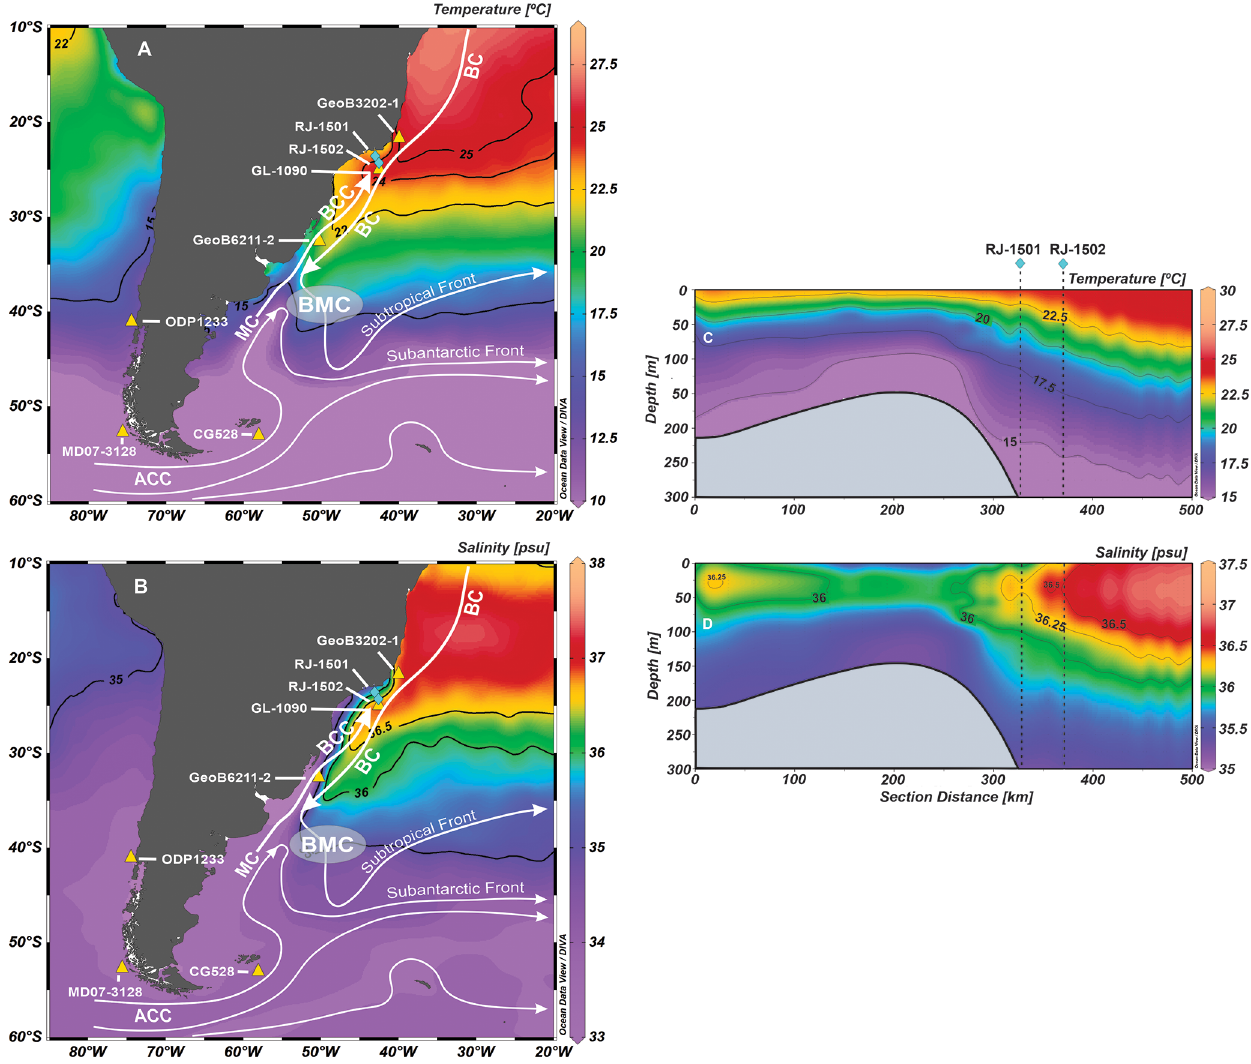
Figure 1. Position of marine sediment cores RJ-1501 (23 ◦ 58 (cid:48) 14.3 (cid:48)(cid:48) S, 43 ◦ 06 (cid:48) 35.1 (cid:48)(cid:48) W; 328m water depth) and RJ-1502 (24 ◦ 32 (cid:48) 57.6 (cid:48)(cid:48) S, 42 ◦ 55 (cid:48) 42.9 (cid:48)(cid:48) W; 1598m water depth) in the upper and lower continental slope of the subtropical western South Atlantic and other cores (GeoB3202-1, GL-1090, GeoB6211-2, CG528, MD07-3128, and ODP1233) discussed in this study. The maps feature the annual (a) sea surface temperature and (b) sea surface salinity. The transects on panels (c) and (d) show the annual water mass structure relative to temper- ature and salinity, respectively. Acronyms on panels (a) and (b) define the Brazil Current (BC), Brazilian Coastal Current (BCC), Malvinas Current (MC), Brazil–Malvinas Confluence (BMC), and Antarctic Circumpolar Current (ACC). Temperature and salinity grids are derived from the World Ocean Atlas 2013 (Locarnini et al., 2013; Zweng et al., 2013). This figure was produced using the software Ocean Data View (Schlitzer,